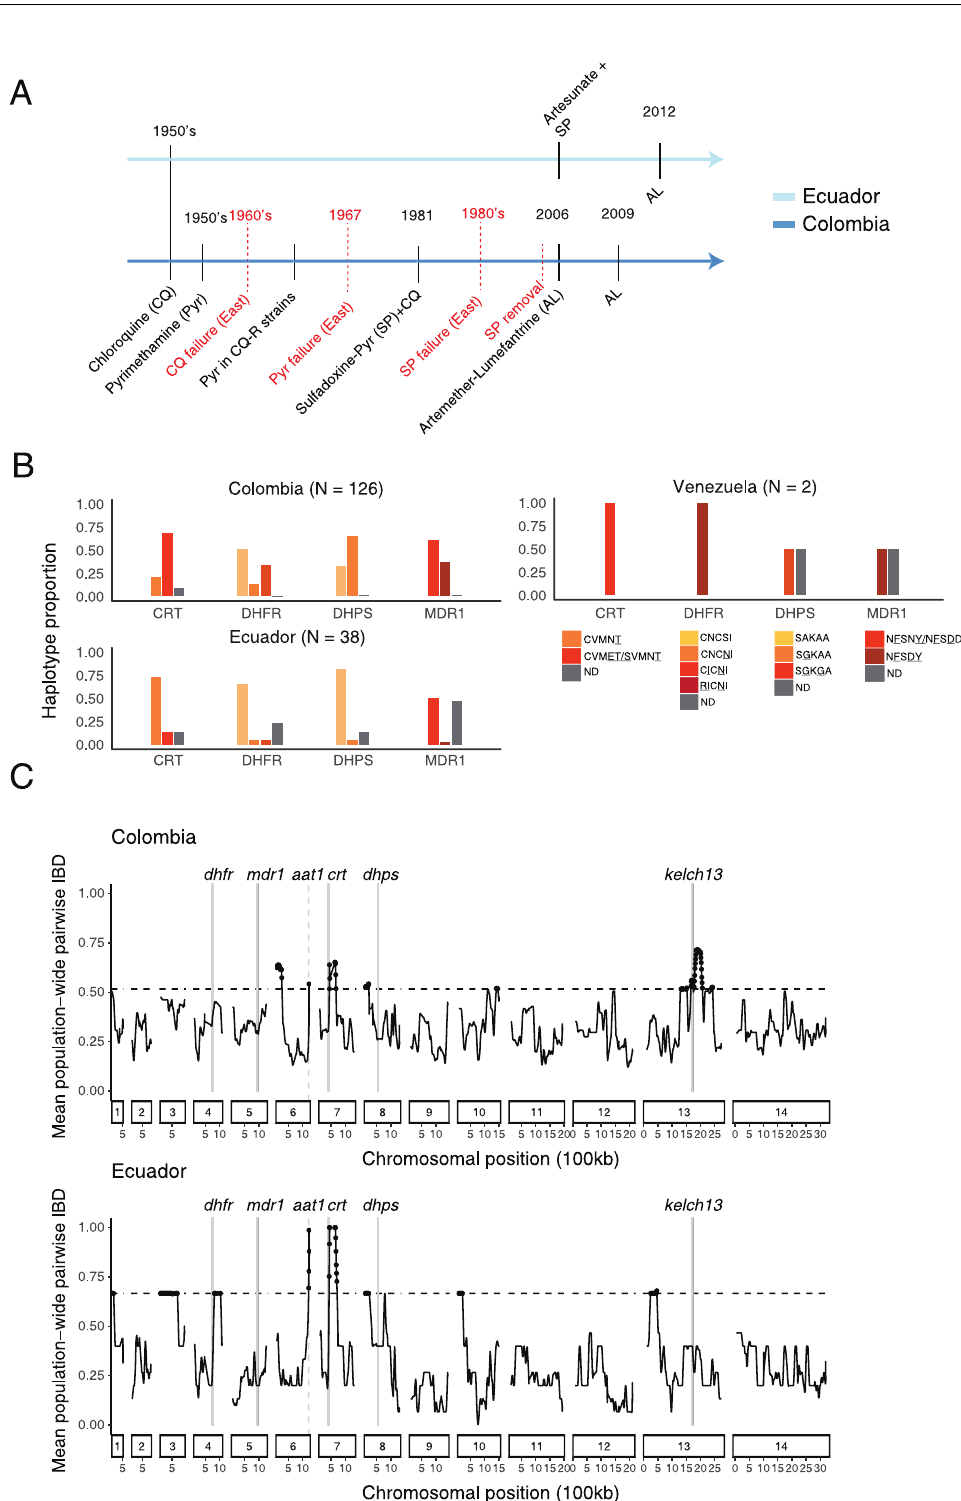
Fig 5. Drug selection across the Pacific Coast Region. (A) Timeline of official antimalarial usage for treatment of P . falciparum malaria (black) and documented emergence of antimalarial resistance (red) in Ecuador (light blue) and Colombia (dark blue). Data are based on epidemiological information from the respective country-level Institutes of Health. (B) Drug-resistance haplotypes in the 166 monoclonal samples collected 2013–2017, colored by wild-type (WT) allele, or by the drug resistance haplotype shown as the amino acid sequence, with an underline referring to the